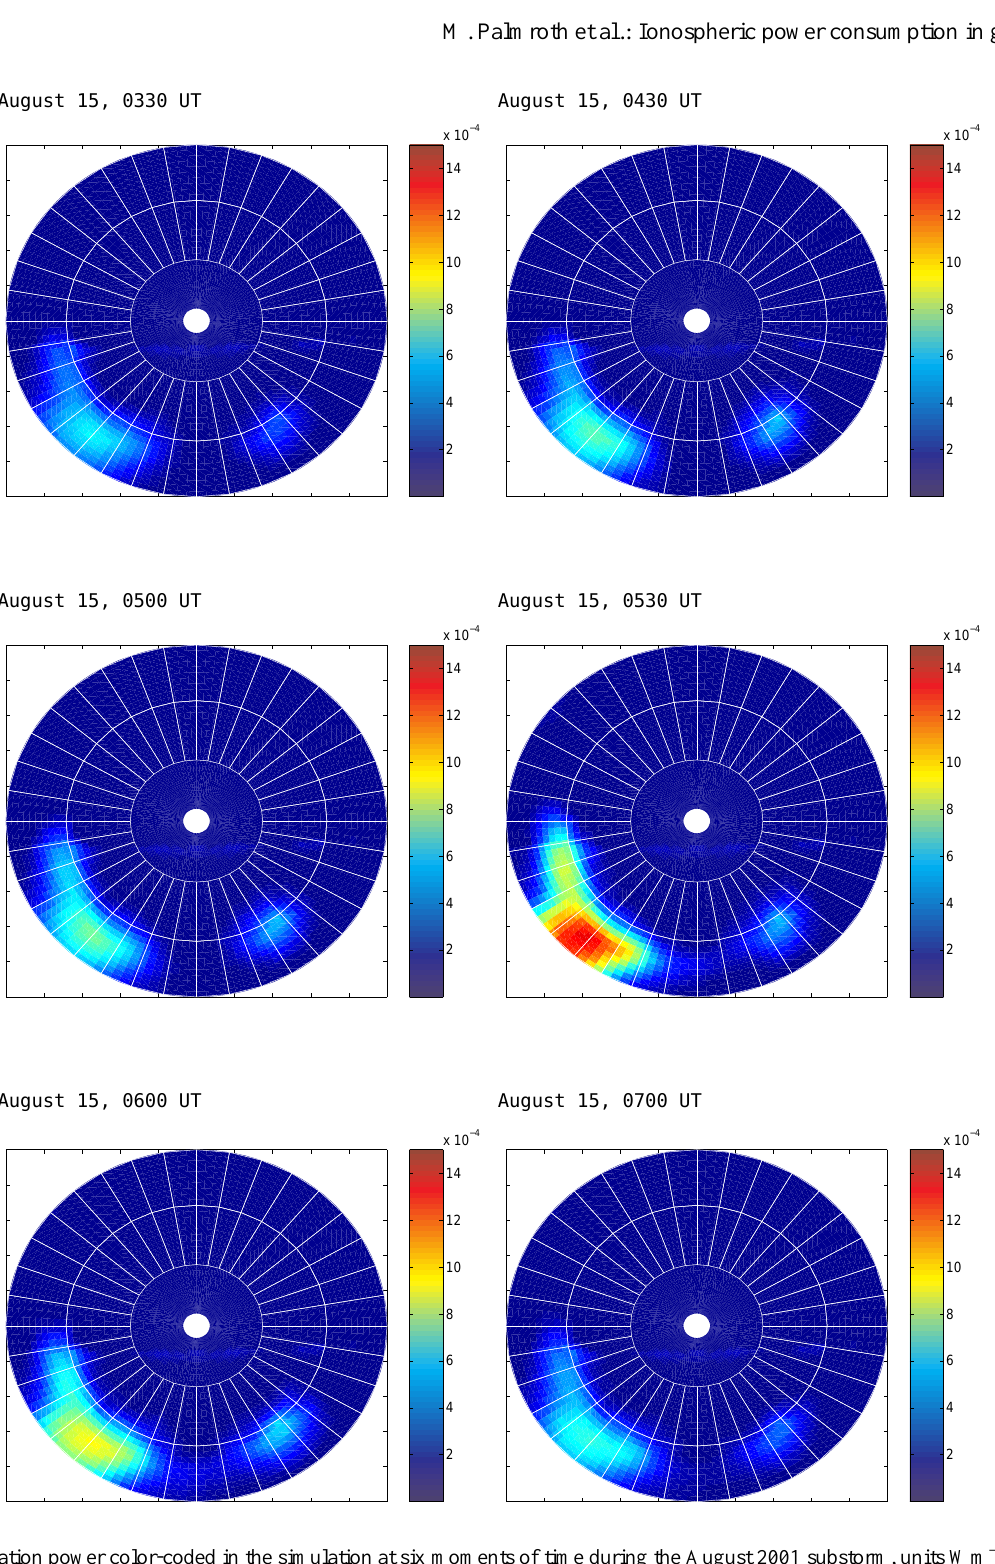
area, and in the polar cap, respectively. Contrary to the